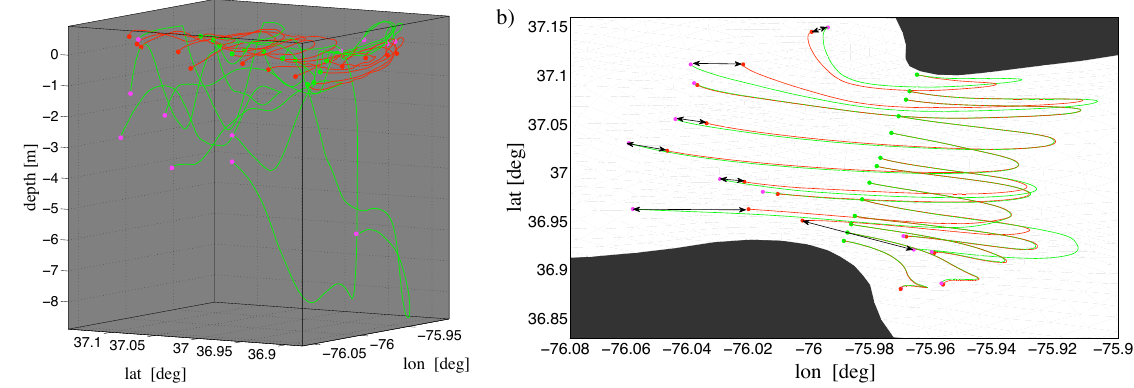
Fig. 5. Comparison of the geometry of trajectories evolving according to the fully 3-D Quoddy velocity field (green) and trajectories confined to evolve within the second sigma layer (red). Both types of trajectories evolve from initial locations within the second sigma level, 6 2 . Clearly, the sigma levels (with the exception of 6 1 which coincides with the free surface) bear little relation to material surfaces. (b) Comparison of the same trajectories as in (a) but projected onto the (lon, lat) coordinates. Although there are significant discrepancies in the end locations of the computed trajectories, the overall correlation between the 3-D and the sigma confined trajectories is surprisingly good. M. Branicki and R. Malek-Madani: Lagrangian structure of flows in the Chesapeake Bay